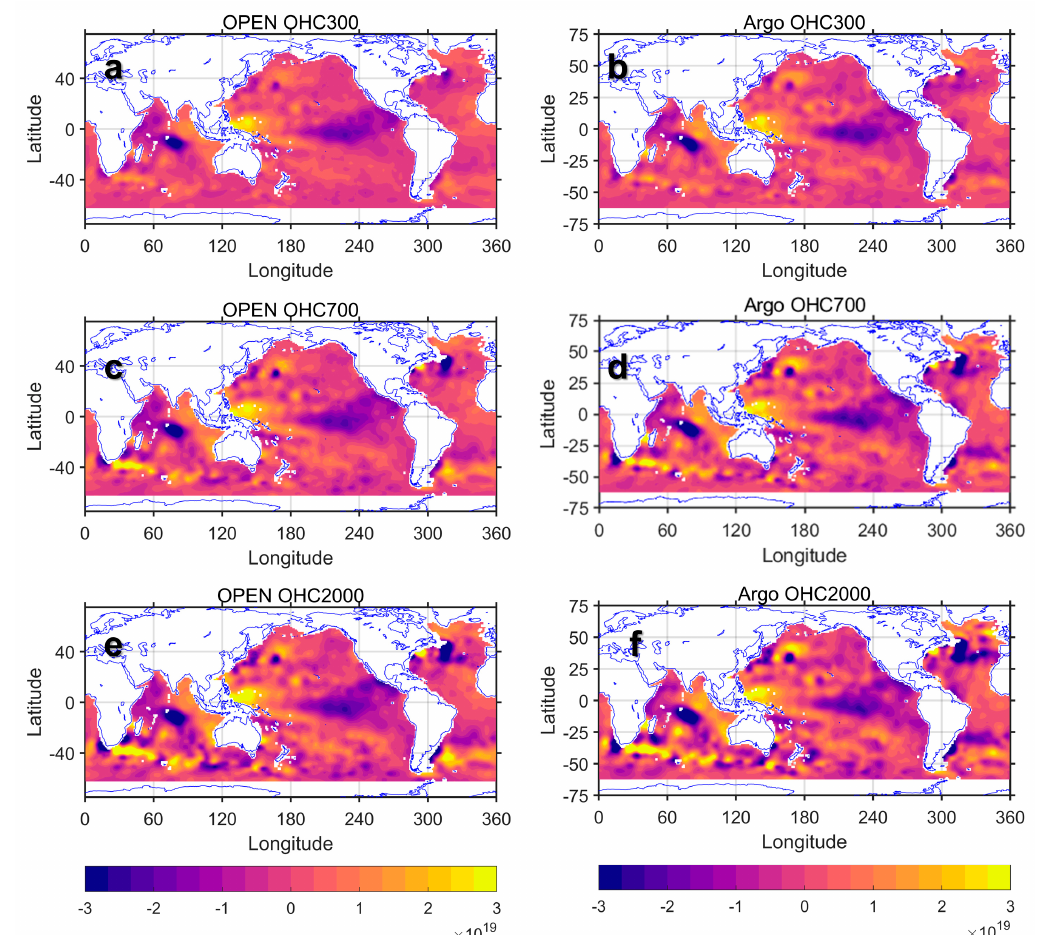
Figure 2. The ocean heat content (OHC) (unit: Joule) at three depths (top: 0–300 m; middle: 0–700 m; bottom: 0–2000 m) for (left) OPEN-hindcasted and (right) Argo data in January 2011. The network was trained with 12-month data from 2010.